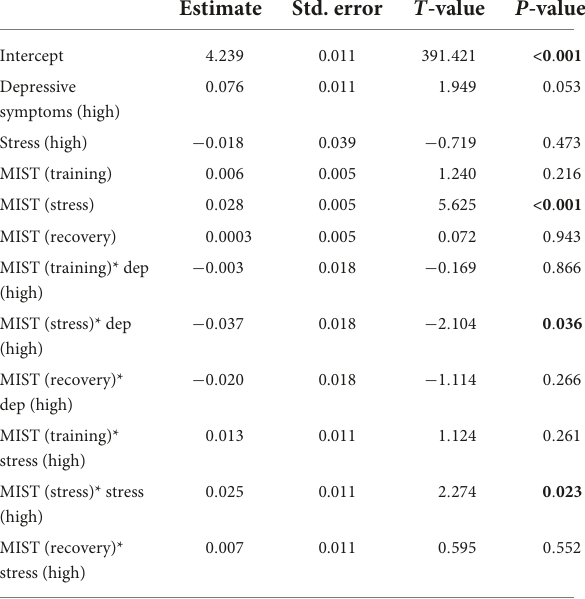
TABLE 2 Result of the linear mixed model on reactivity during the stress task (MIST).